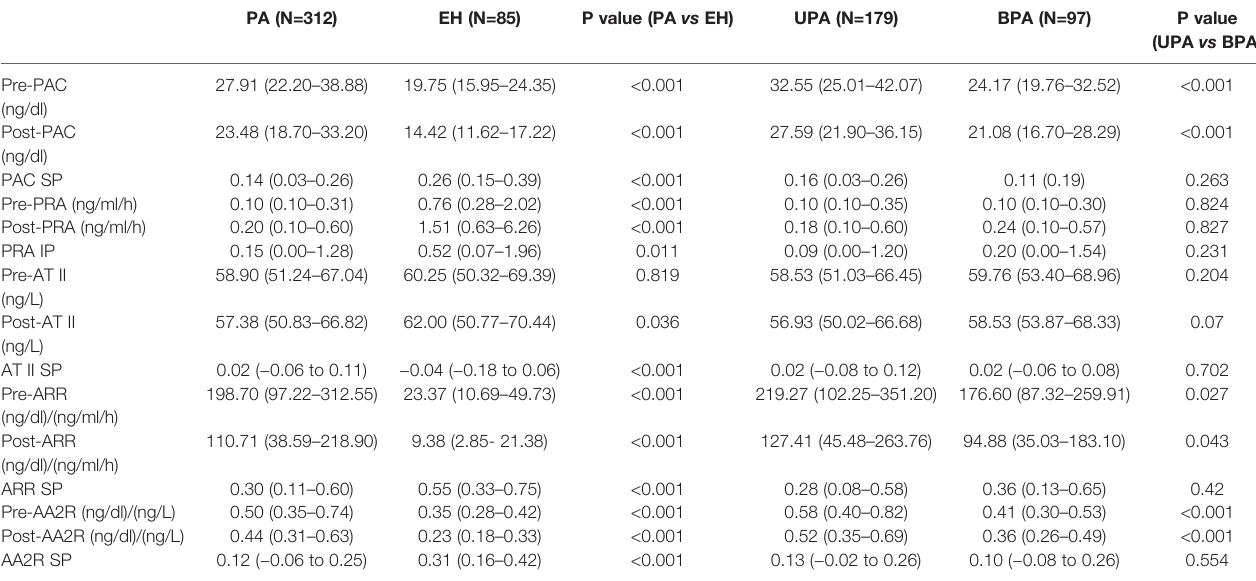
TABLE 2 | Comparison of CCT-associated data between groups (PA vs EH and UPA vs BPA). PA (N=312) EH (N=85) P value (PA vs EH) UPA (N=179) BPA (N=97) P value